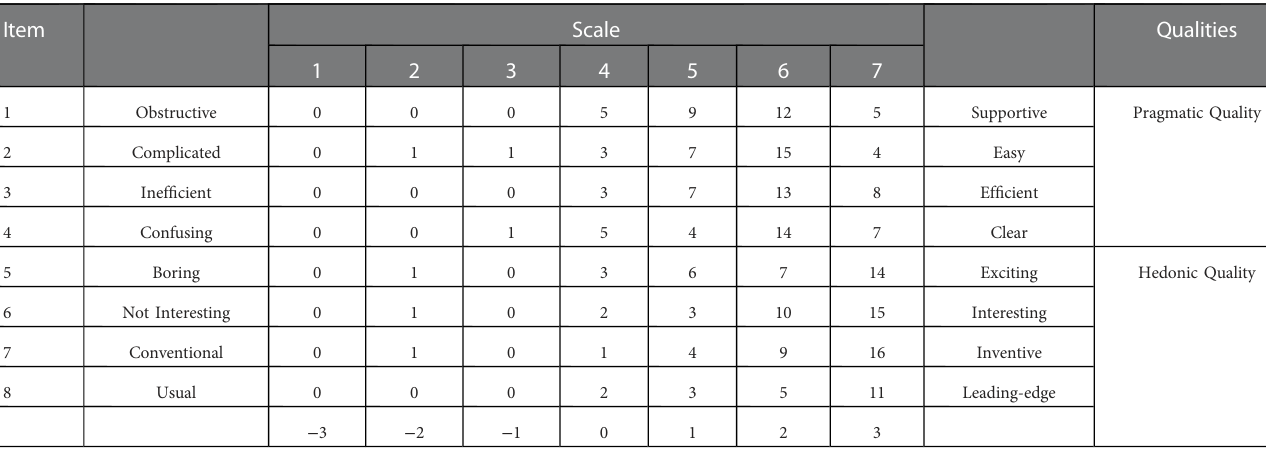
TABLE 1 Summary of user experience questionnaire results.